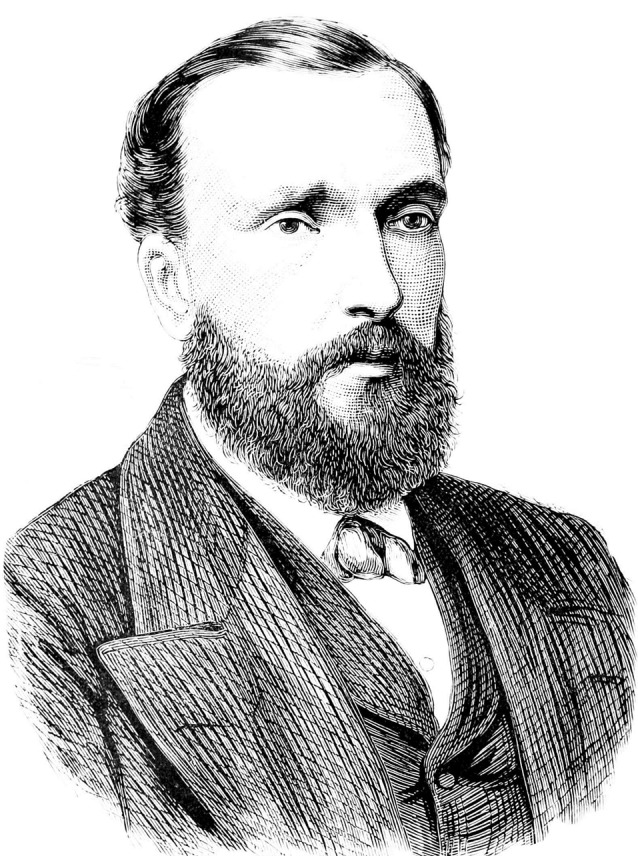
Portrait of Bastian (1875).